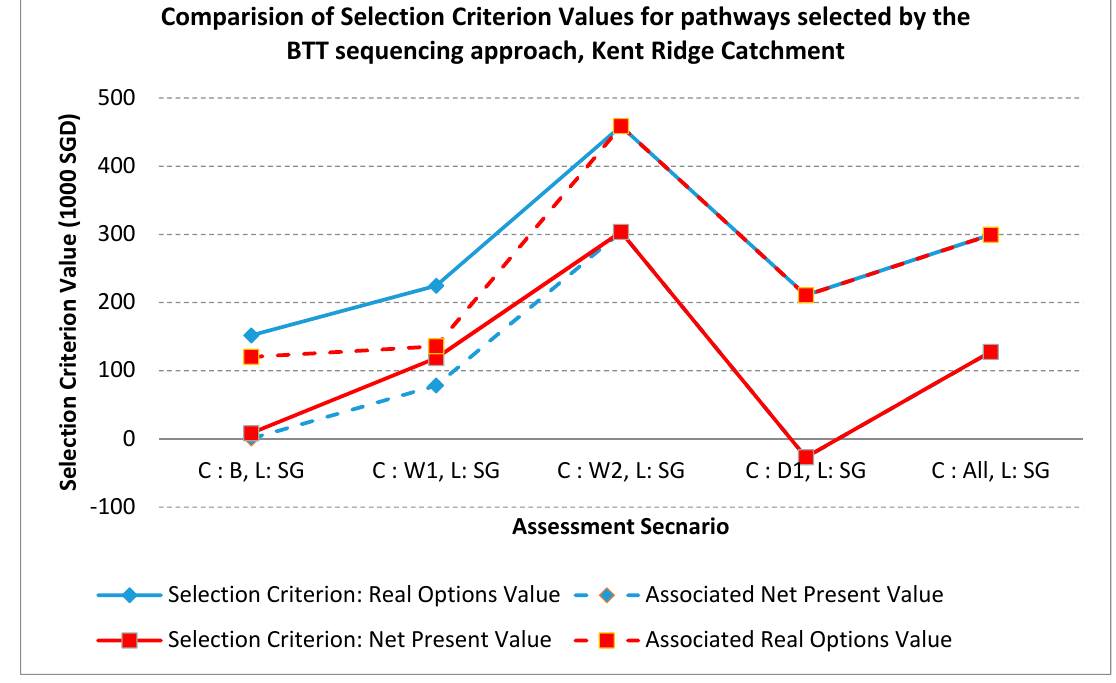
Figure 8. Comparison of Selection Criterion Values for pathways selected by the BTT sequencing approach under different climate (C) and landuse (L) scenarios, Kent Ridge Catchment.